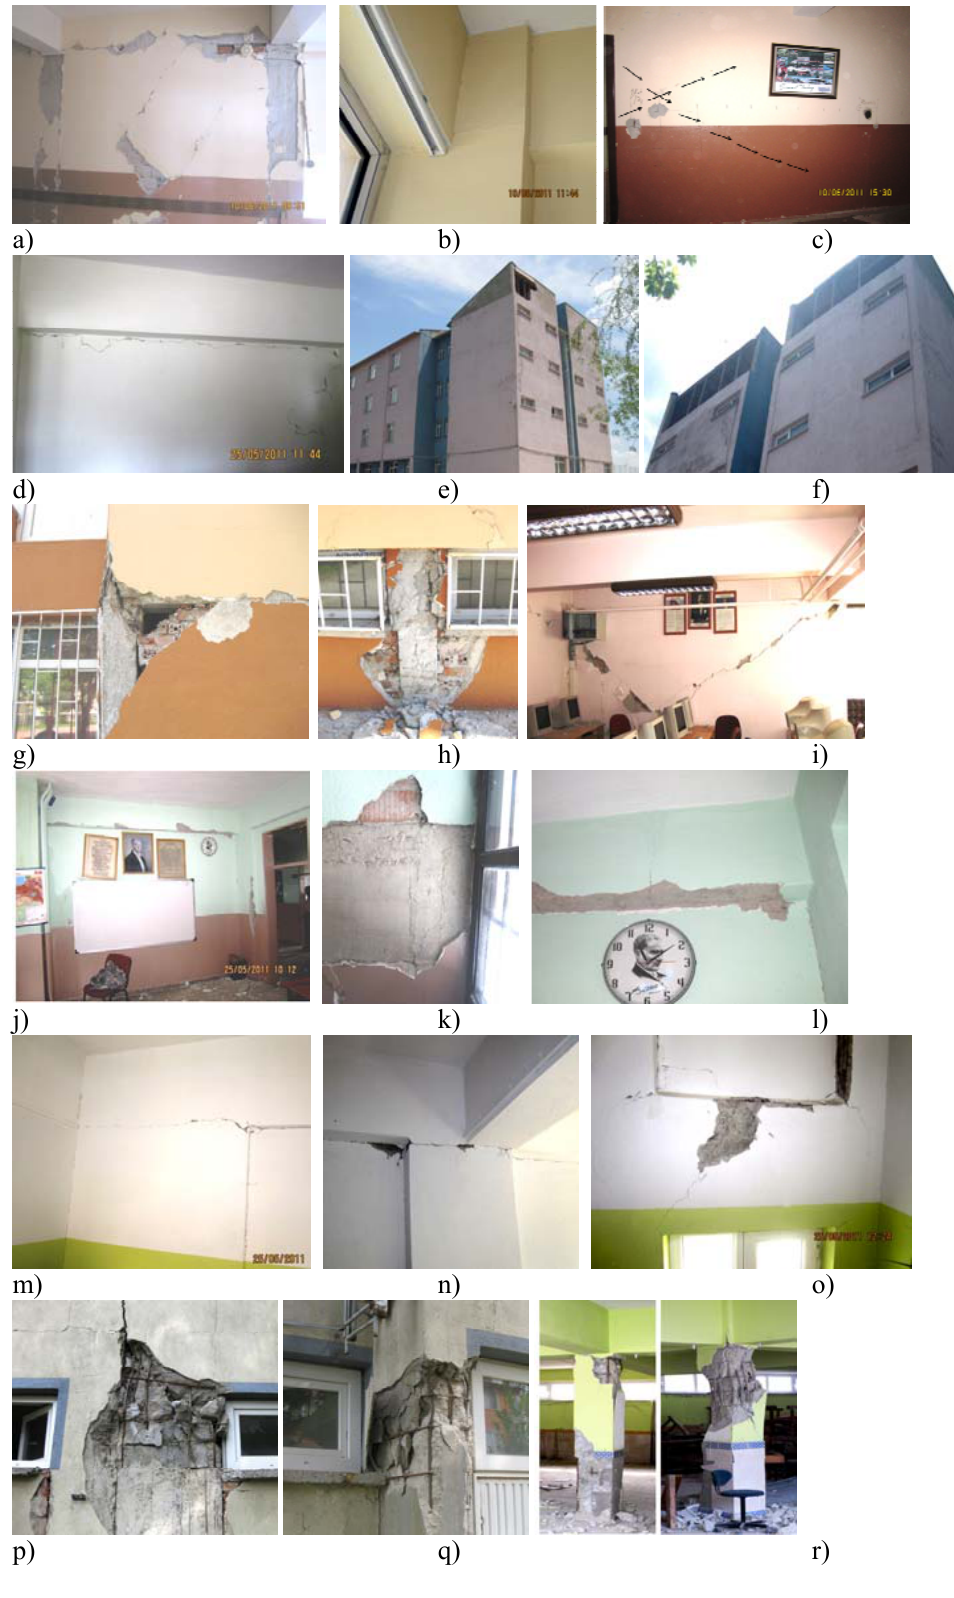
Fig. 5. Observed typical damages at investigated buildings.